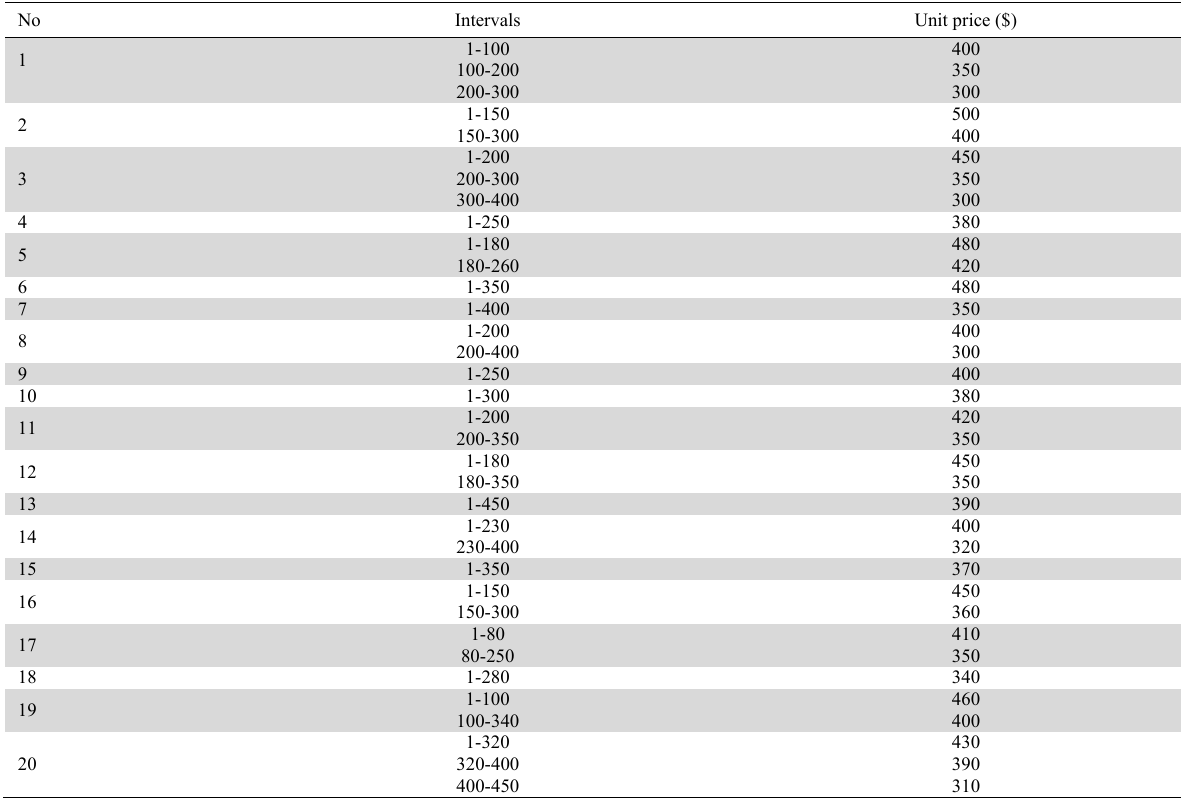
Discount intervals for the problem with 20 suppliers